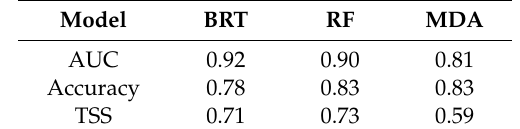
Table 3. Performance of the modeling results.